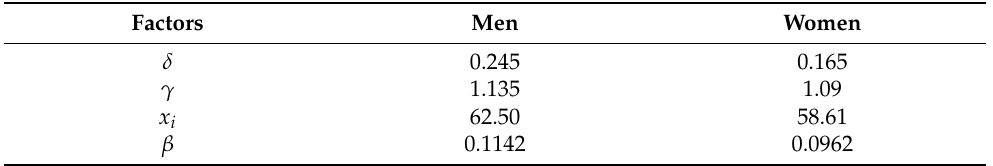
Table 1. Dependent excess mortality factors for the level of severe and high dependency in Spain. Source: